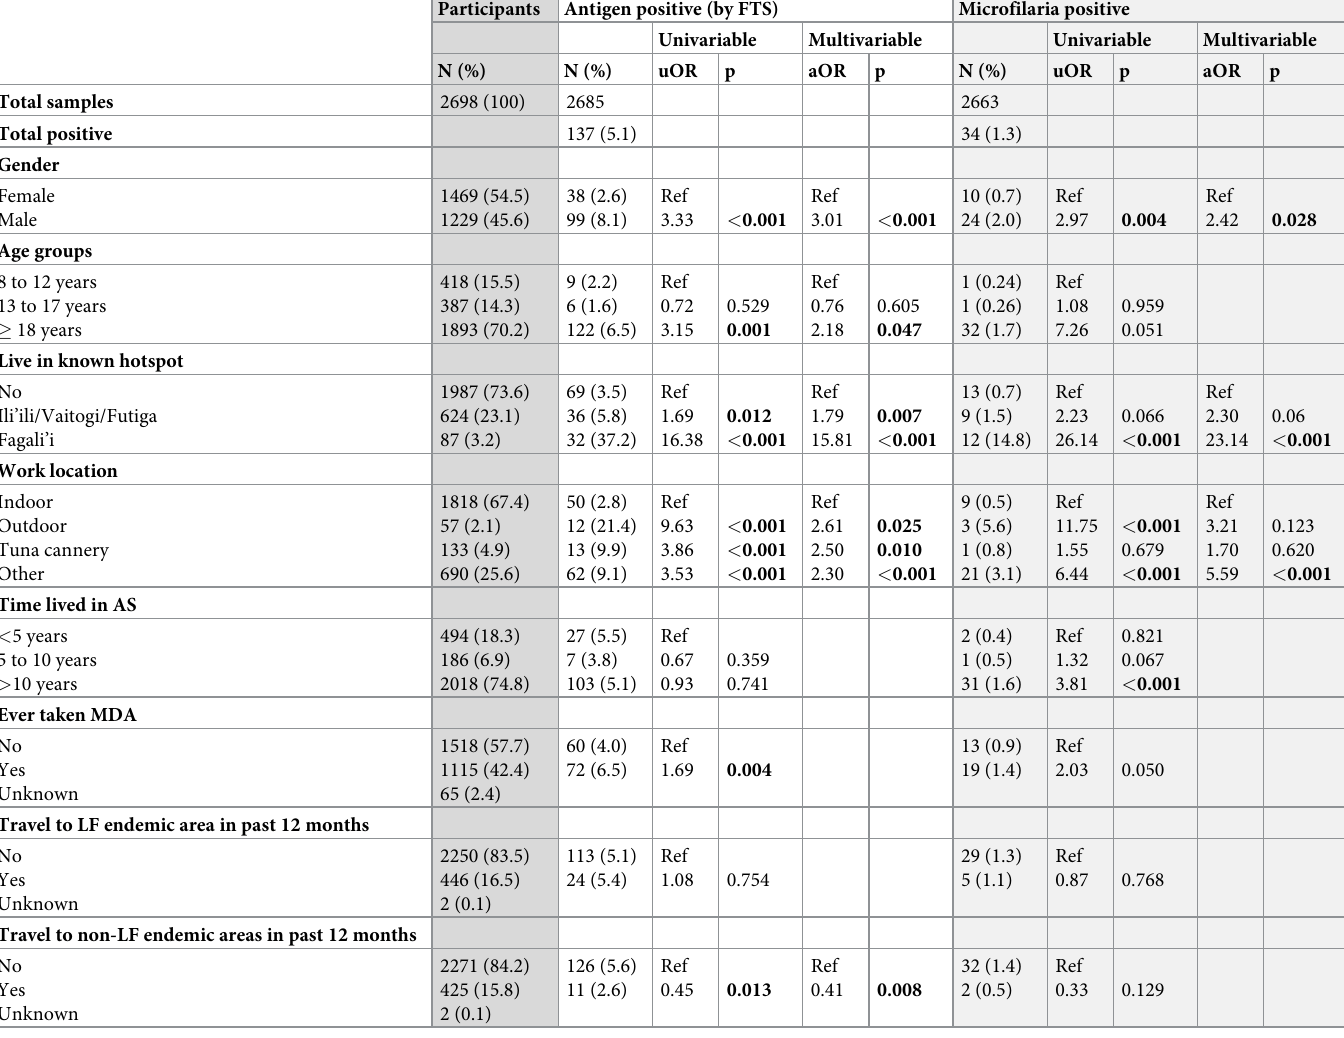
Table 1. Community survey of residents aged � 8 years: Summary of demographic and behavioural factors, and their associations with antigen-positive and micro- filaria-positive results on univariable and multivariable logistic